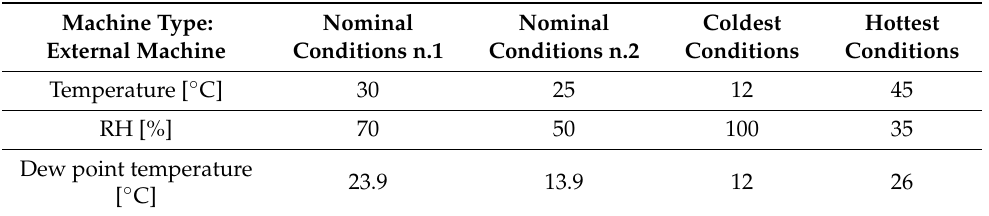
Table A1. Dew point for external machine normalised conditions.